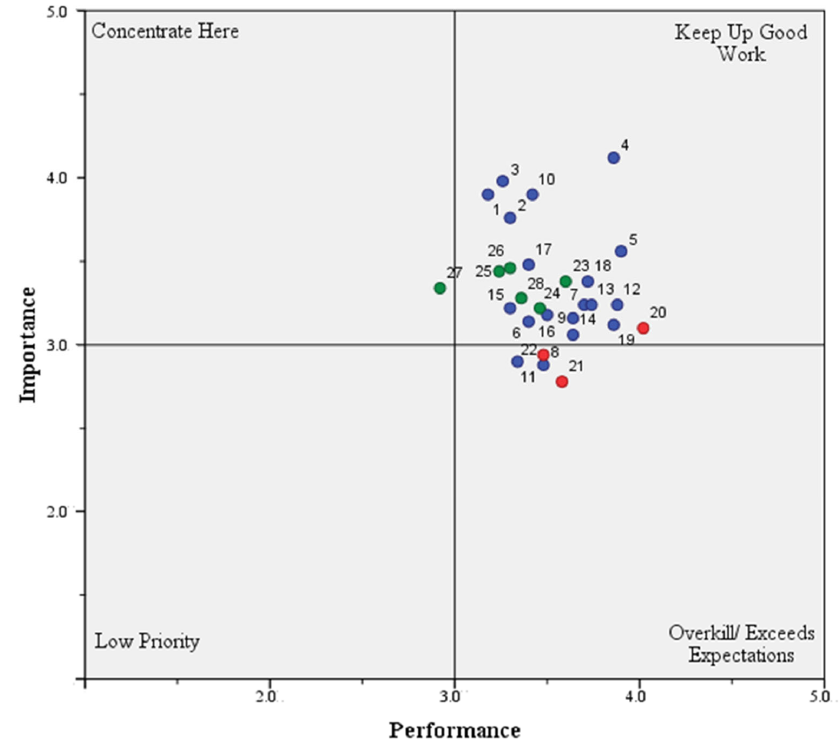
Figure 4. Scale ‐ centers for selected attributes of FSC certification (blue: business ‐ related attributes; Figure 4. Scale-centers for selected attributes of FSC certification (blue: business-related attributes; red: social attributes; green: environmental attributes). red: social attributes; green: environmental